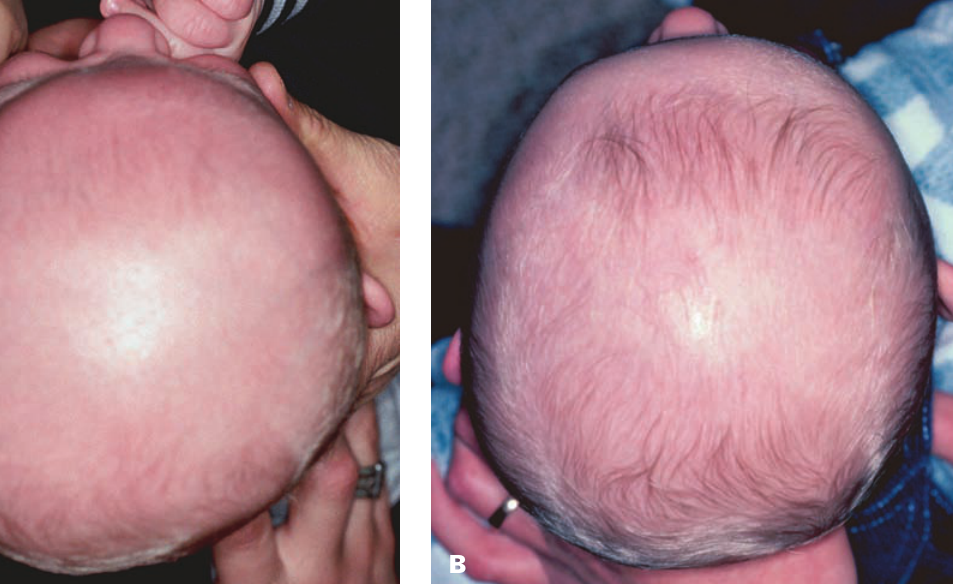
Figure 4 A. Pretreatment ver- tex view of the head of a 4-month-old in- fant with right poste- rior positional plagio- cephaly. B. Results after 2 months of treatment by cranial